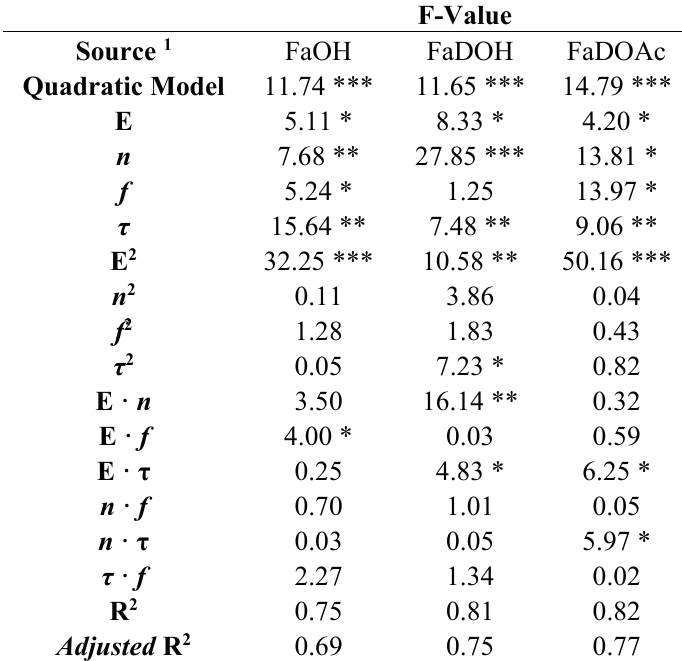
Table 2. Analysis of variance of the second-order models for the polyacetylenes in mild PEF-treated carrot